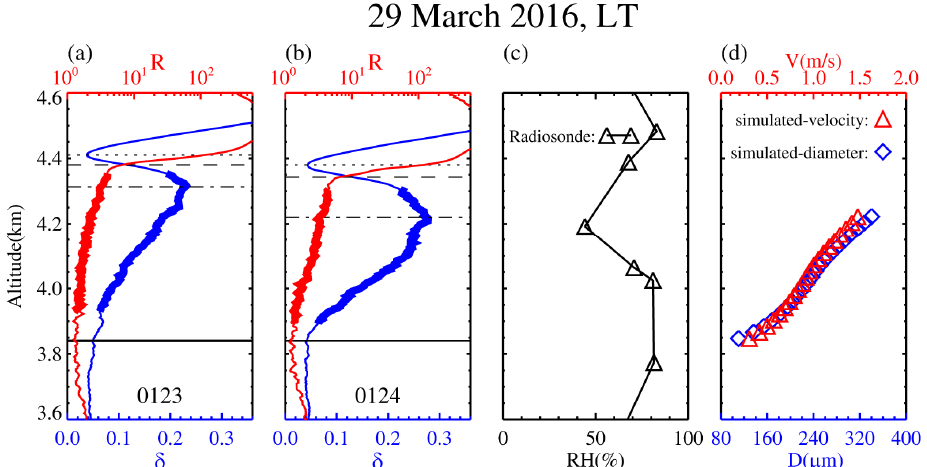
Figure 8. Two sequential 1-min profiles of backscatter ratio (red) and depolarization ratio (blue) obtained by the polarization lidar at ( a ) 0123 and ( b ) 0124 LT on 29 March 2016, ( c ) Profile of relative humidity over ice from local radiosonde (black with triangle) around 2000 LT on 28 March 2016, and ( d ) altitude variations of ice particle radius (blue diamond) and corresponding terminal velocity (red triangle) calculated with a conventional ice particle sublimation model mentioned in Section 2.3. The parent cloud base height (R ~ 7.0) and δ -minimum height are indicated by dash and dotted lines, respectively. The depolarization ratio had values larger than 0.2 at altitudes of 4.1-4.3 km, showing the presence of ice crystals. Note that the ice virga layer (~3.9-4.35 km) showed coherent structure and altitude shift as seen from the two sequential 1-min δ profiles. This allowed us to estimate the falling